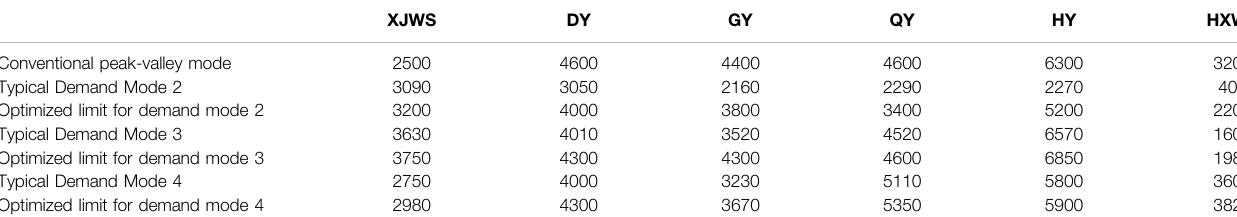
TABLE 3 | Optimized limits for the associated transmission sections(Unit:MW).